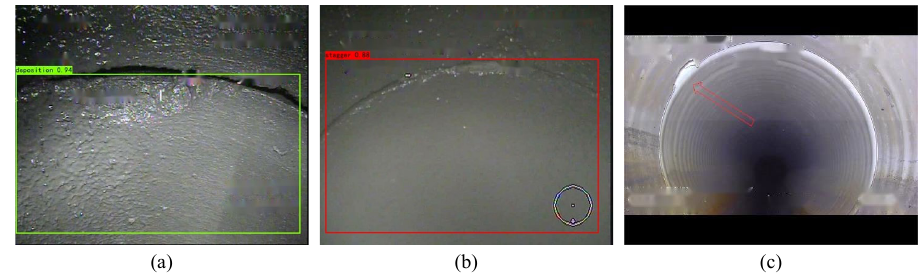
Figure 13. Examples of false detected defects. ( a ) crack misidentified as deposition; ( b ) crack misidentified as stagger; ( c ) crack was not detected.